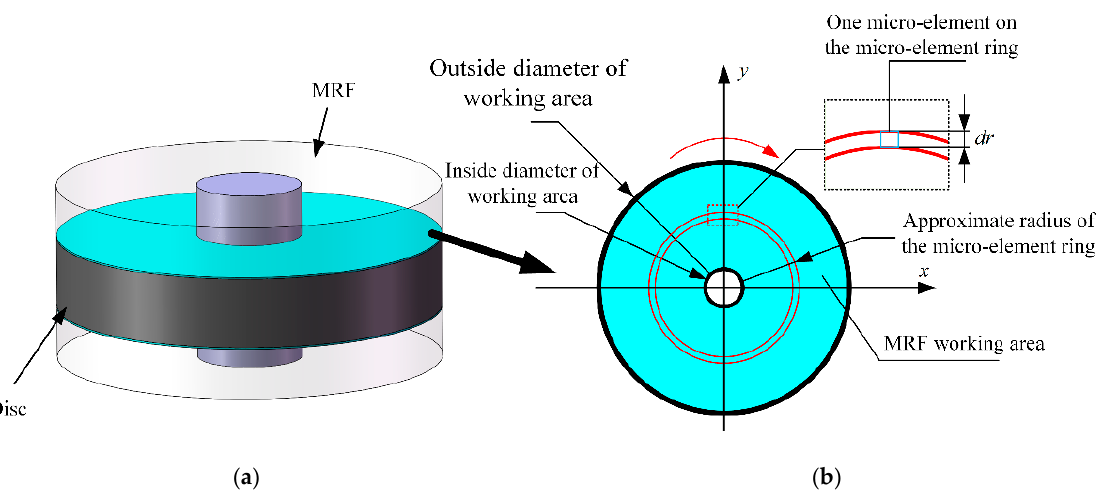
Figure 10. MRF shear force versus velocity distribution.